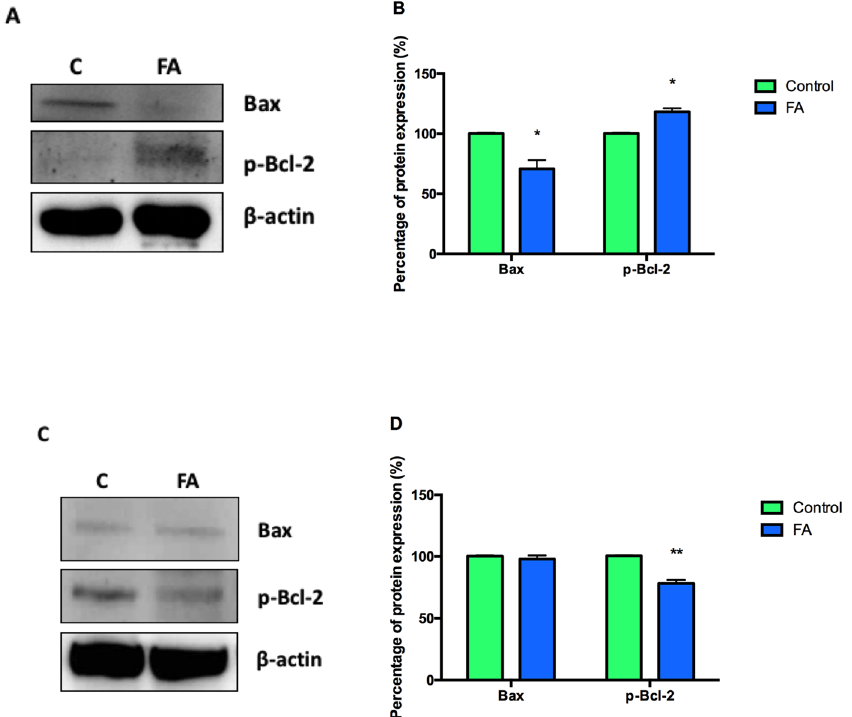
Figure 4. Effect of FA on apoptotic regulator proteins Bax and p-Bcl-2 in PBMCs and Thp-1 cells. Protein expressions of Bax and p-Bcl-2 in healthy PBMCs ( A ) and Thp-1 cells ( C ). Percentage of Bax and p-Bcl-2 protein expression in healthy PBMCs ( B ) and Thp-1 cells ( D ). Percentage of protein expressions were represented as mean ± SD. * p < 0.05 relative to respective control; ** p < 0.005 relative to respective